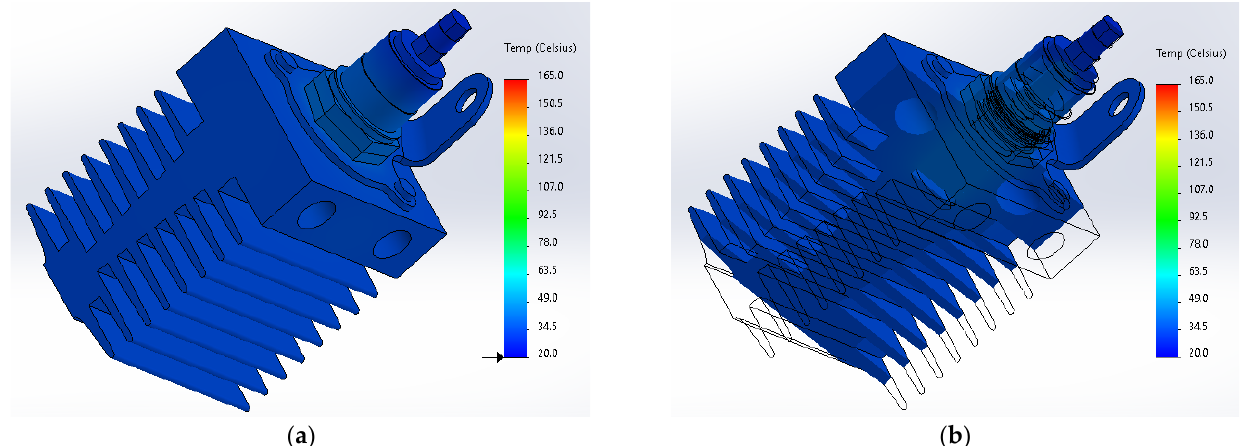
Figure 12. The simulation result showing the heat sink for a power of P j = 11.56 W: ( a ) side view; ( b ) cross section. The temperature ranges from 20 °C to 165 °C.